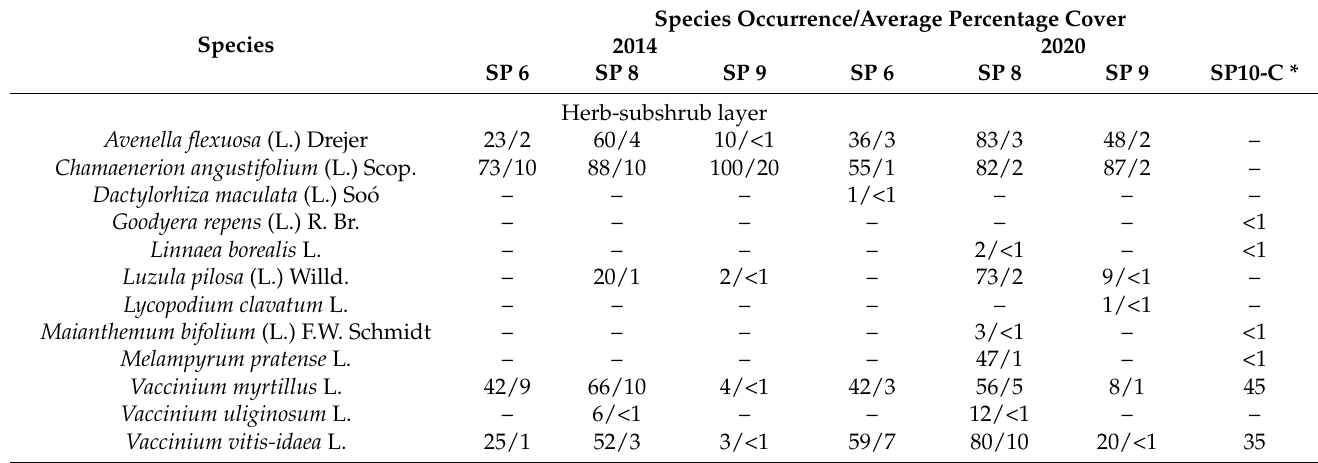
Table 2. Occurrence and percentage covers of species of the herb-subshrub and moss-lichen layers in permanent sample plots in 2014 and